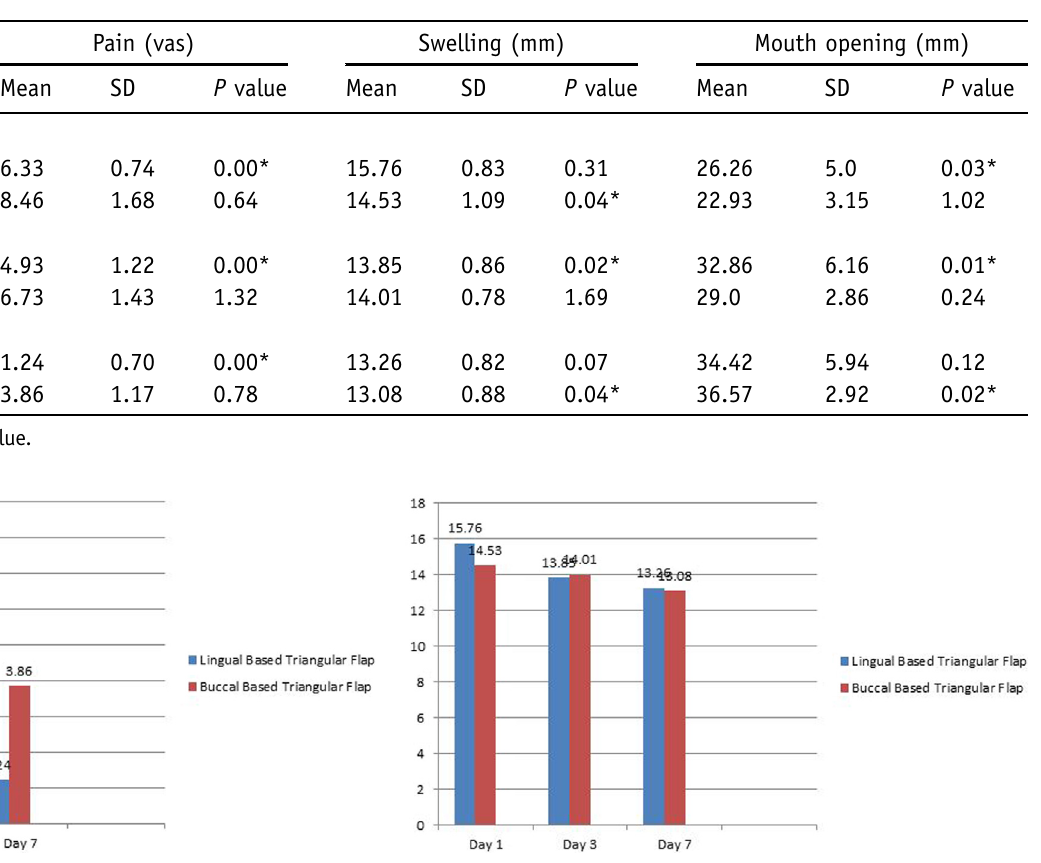
Table I. ANOVA test of signi fi cance for postoperative parameters pain, swelling and mouth opening with mean, standard deviation (SD) and P value for Lingual based triangular fl ap group and Buccal based triangular fl ap group on 1st, 3rd and 7th postoperative days.